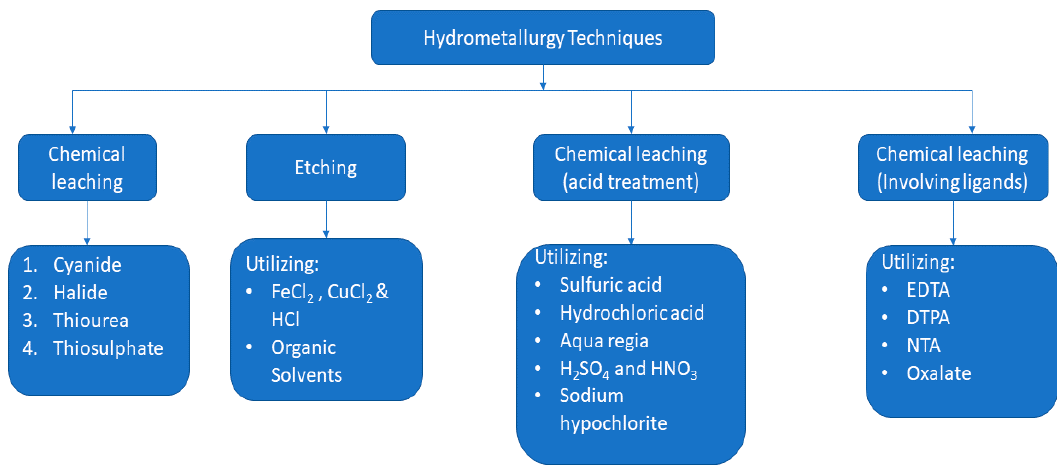
Figure 8. Different hydrometallurgical leaching processes depending on the metals of interest [69].